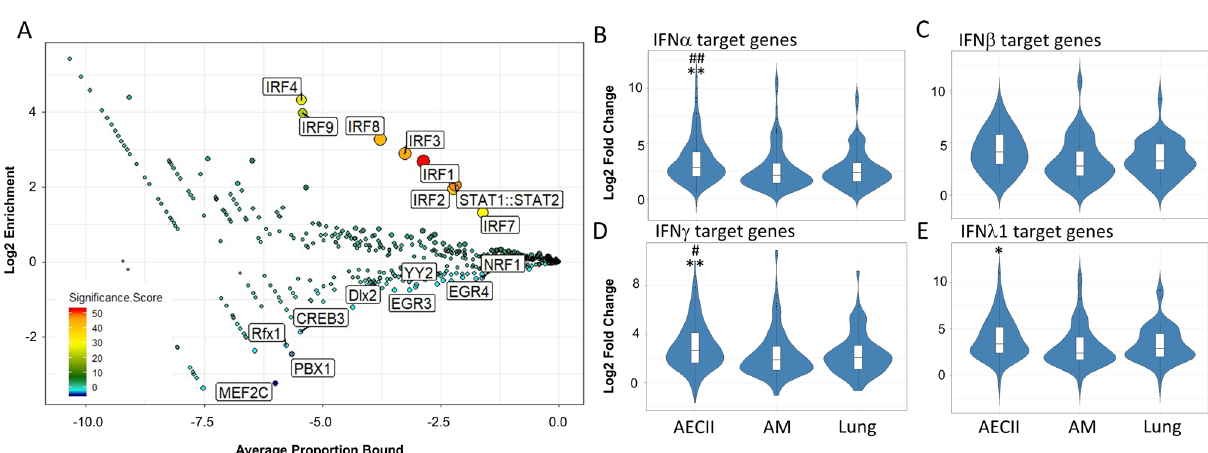
Figure 4. Infection with IAV leads to the broad upregulation of genes in primary human lung cells and in whole lung tissue. ( A ) A set of 302 genes is shared as a common response between all cell types, which is strongly enriched in IRF-responsive genes. Genes that were not regulated in response to IAV served as reference matrix. ( B – E ) Sets of IFN target genes as inferred by Ingenuity pathway analysis (IFNγ, n = 139; IFNλ1, n = 64; IFNα, n = 128; IFNβ, n = 41) show a significantly stronger average induction upon viral infection in AECII compared to AM and lung as determined by ANOVA with tukey correction for multiple testing. * p < 0.05, ** p < 0.01 versus AM # p < 0.05, ## p < 0.01 vs. human